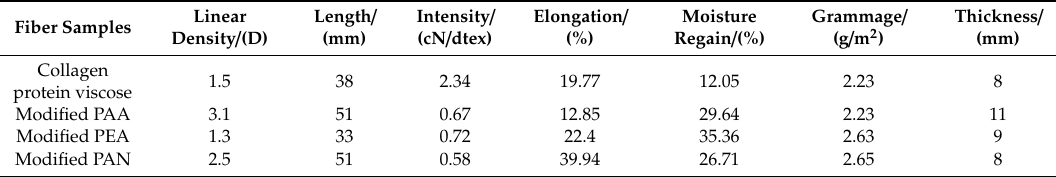
Table 1. Physical properties of hygroscopic exothermic fiber